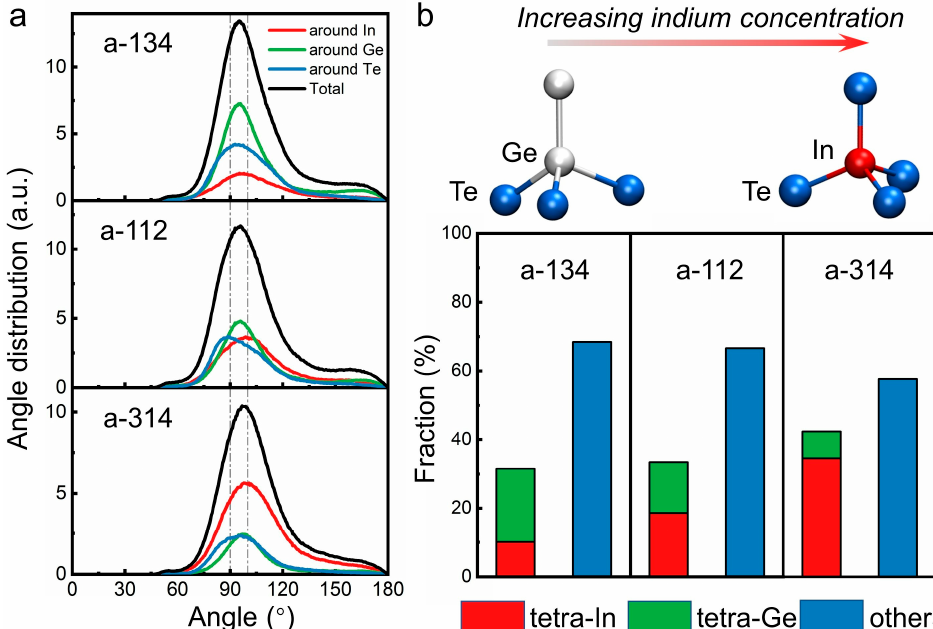
Figure 2. ( a ) Angle distribution functions (ADFs) for the amorphous structures of the three In-Ge-Te compositions. The central bond angles for perfect tetrahedron (109.5°) and octahedron (90°) are marked as dashed lines in ADF plots. ( b ) Ratios of tetrahedral motifs in the three amorphous structures. Typical Ge- and In-centered tetrahedral motifs (short as tetra-In and tetra-Ge) in the amorphous structures are shown on the top panel.